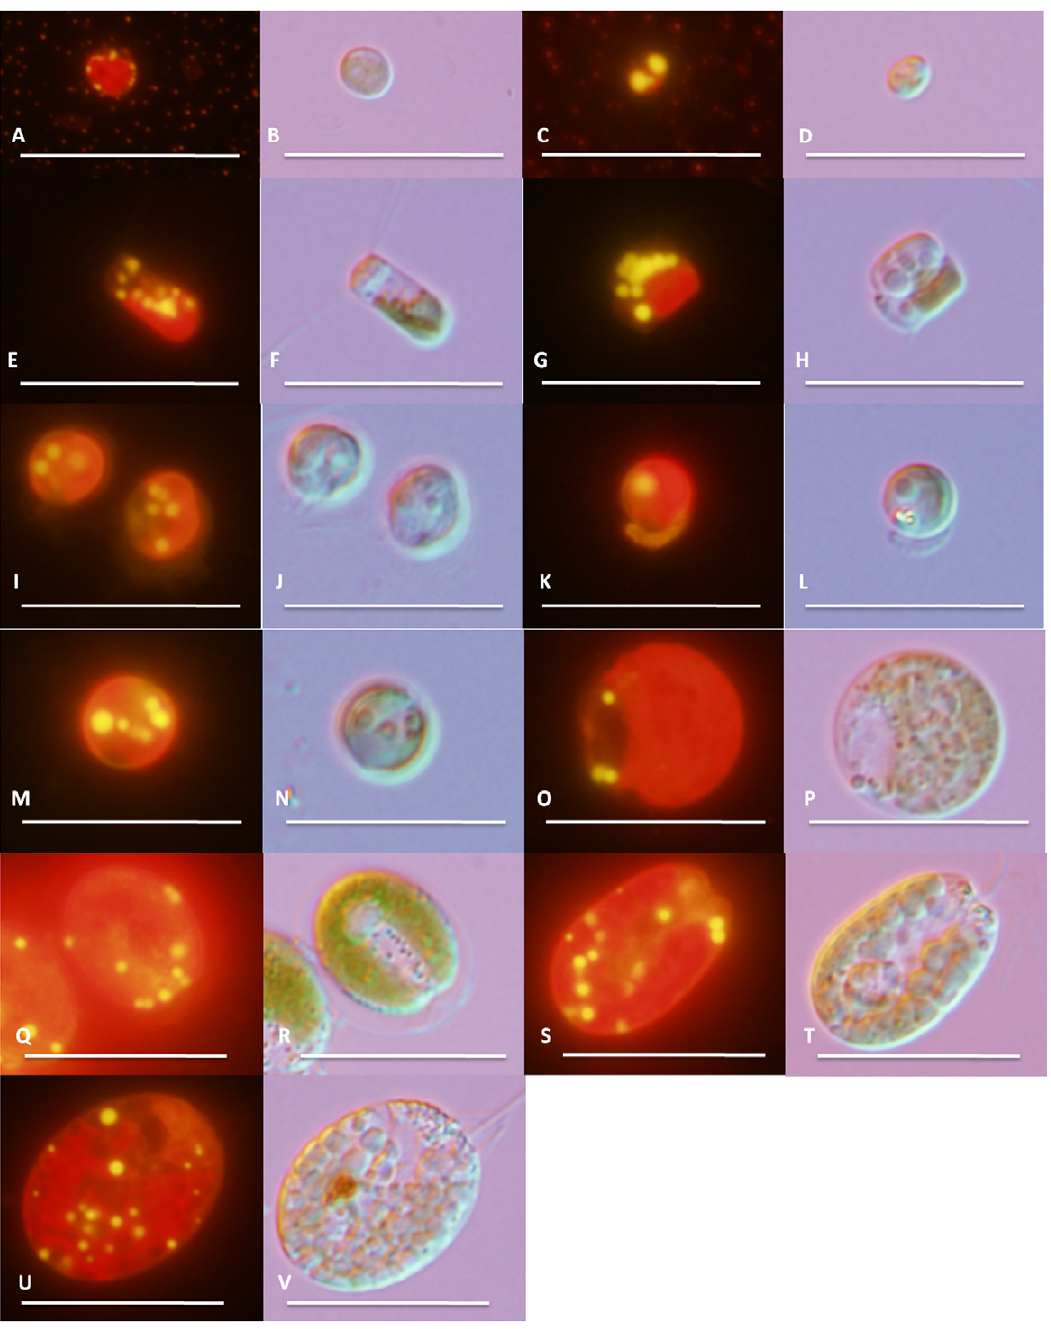
Figure 1. Epifluorescent (A, C, E, G, I, K, M, O, Q, S, U) and differential interference contrast (B, D, F, H, J, L, N, P, R, T, V) images of eleven microalgae used in this study. Chlorella sp. BR2 (A, B), Nannochloropsis sp. BR2 (C, D), Chaetoceros muelleri (E, F), Chaetoceros calcitrans (G, H), Pavlova lutheri (I, J), Pavlova salina (K, L), Isochrysis sp. (M, N), Dunaliella salina (O, P), Tetraselmis chui (Q, R), Tetraselmis sp. M8 (S, T) and Tetraselmis suecica (U, V). All images were taken at 100x magnification. Bars represent 20 m